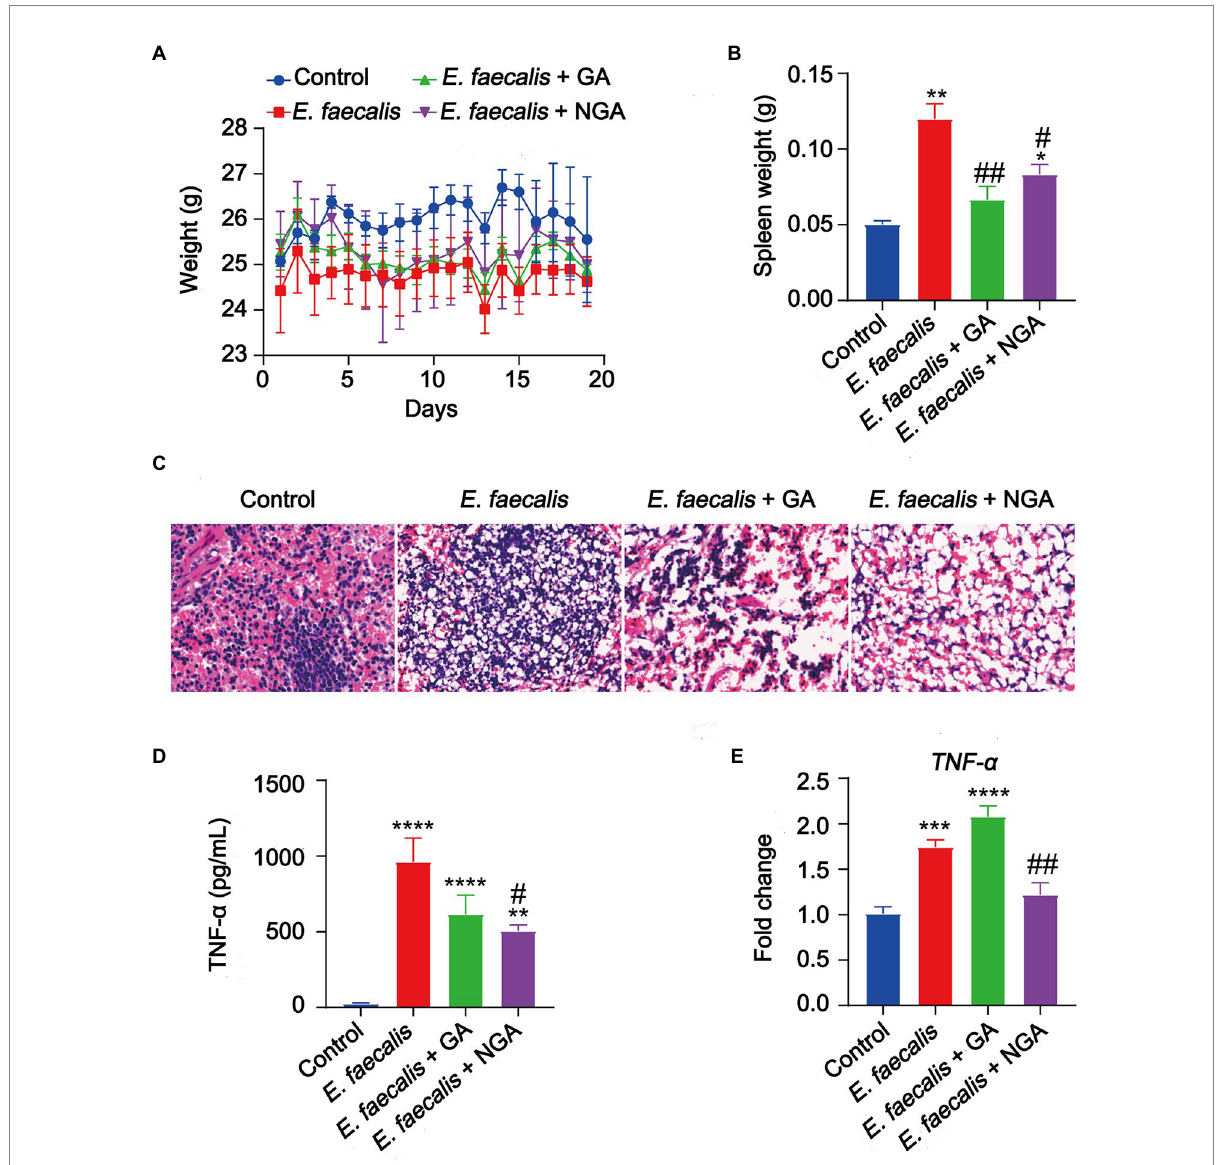
FIGURE 7 Supplementation with GA or NGA improved inflammation induced by E. faecalis . (A) Body weight changes of mice in different groups. (B) Spleen weight were analyzed. (C) Representative histological images of spleen tissues by H&E staining. Amplification, 10 × 40. (D) The serum concentration of TNF- α was detected. (E) The mRNA expression of TNF- α in spleen. The data are presented as the mean ± SEM and were analyzed by ordinary one-way ANOVA with Tukey’s multiple comparisons. * p < 0.05, ** p < 0.01, *** p < 0.001, **** p < 0.0001, compared with control; # p < 0.05, ## p < 0.01, compared with E. faecalis